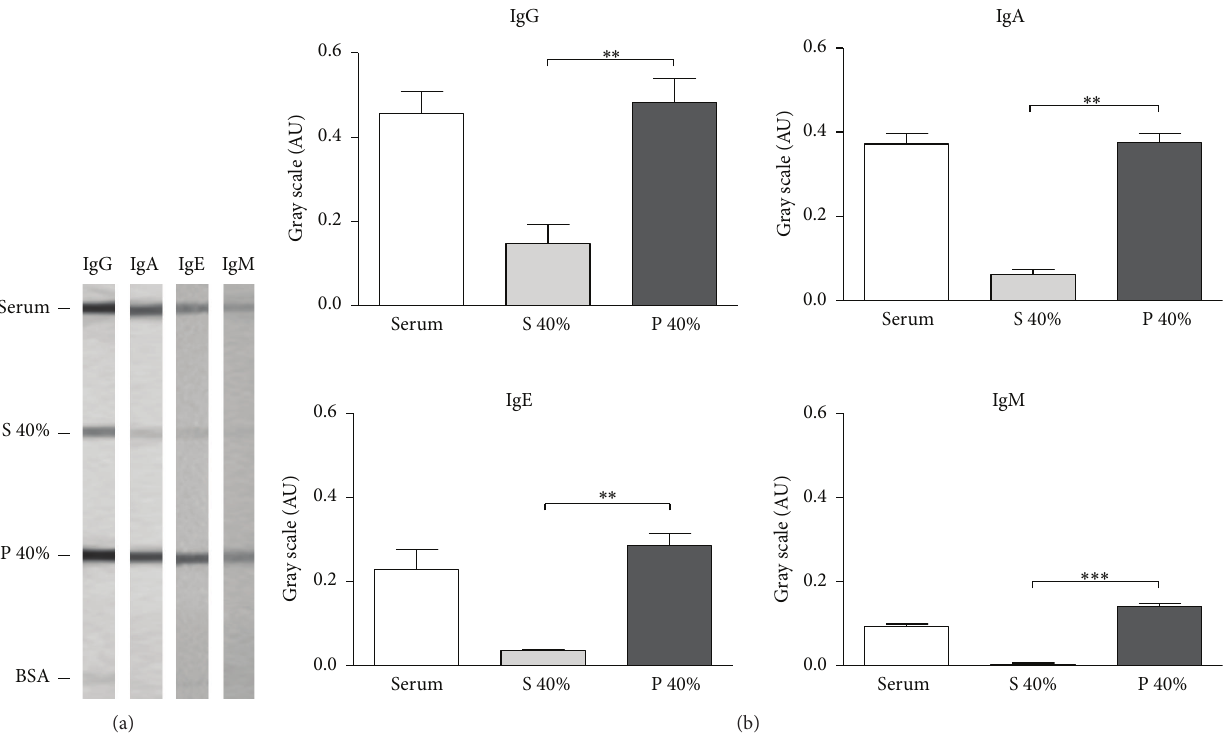
Figure 2: (a) Slot-blots showing reactivity for IgE, IgA, IgG, and IgM in the serum, supernatant (S 40%), and precipitated (P 40%) fractions obtained from precipitation of the serum with 40% ammonium sulfate solution, and bovine serum albumin (BSA) as irrelevant protein. (b) Slot-blot data analysis by measuring the intensity of the bands in gray scale and expressed in arbitrary units (AU). Statistically significant differences were determined by Student’s 𝑡 test ( ∗∗ 𝑃 < 0.01 ; ∗∗ 𝑃 < 0.001 ). Table 1: Demographic and clinical characteristics of the study subjects. Characteristics